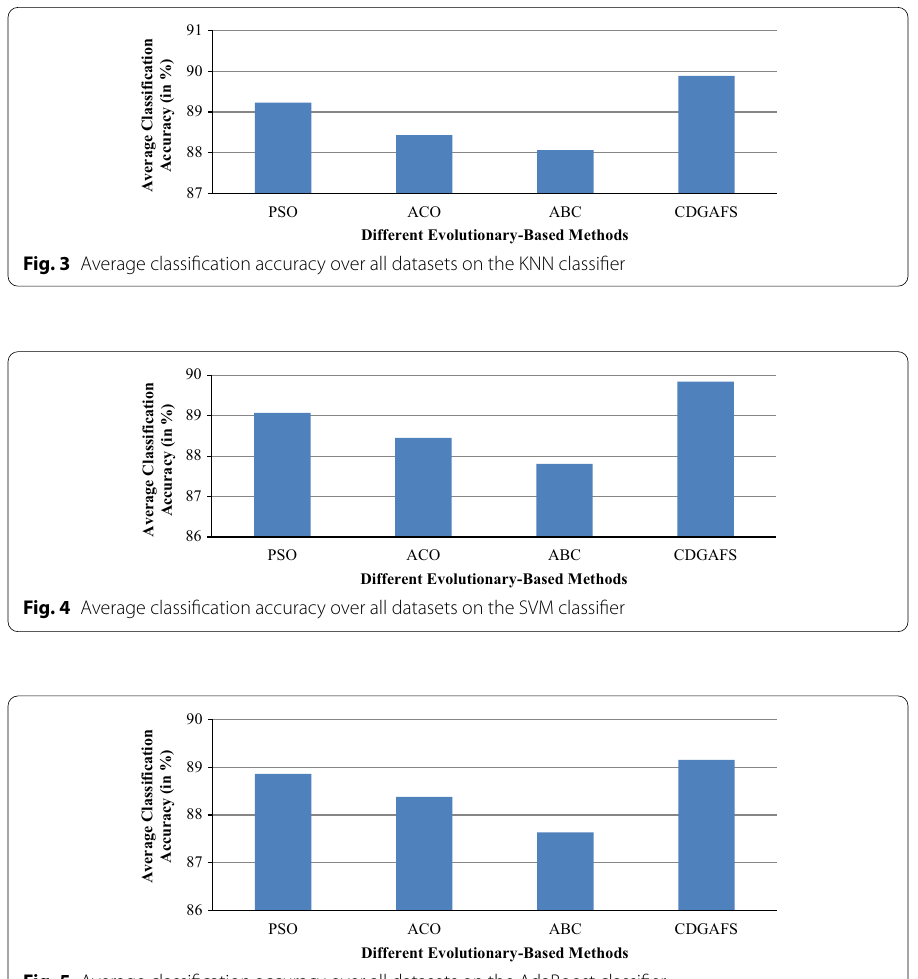
Fig. 5 Average classification accuracy over all datasets on the AdaBoost